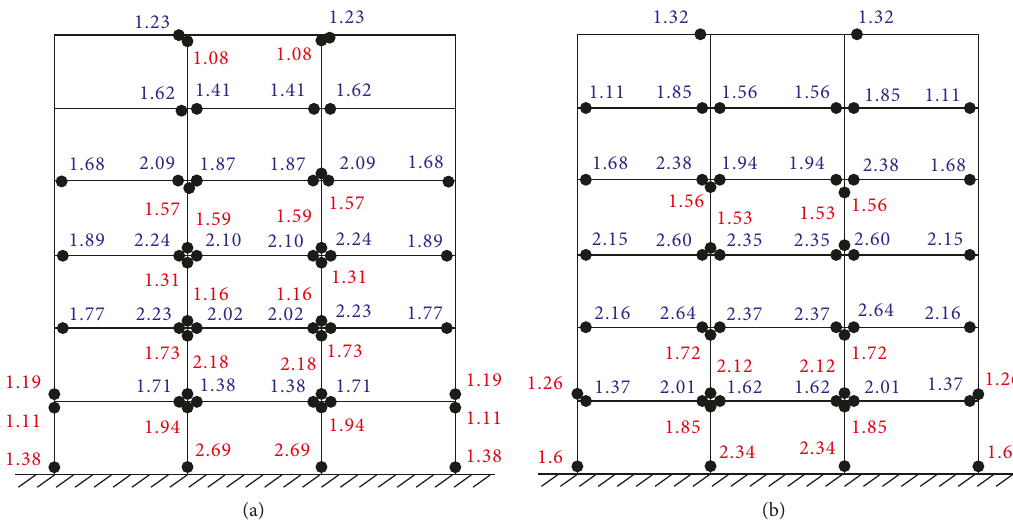
Figure 20: Plastic hinge distribution with 8-degree (0.20 g) fortification intensity. (a) Considering the beam-to-column linear stiffness ratio limit values. (b) Not considering the beam-to-column linear stiffness ratio limit